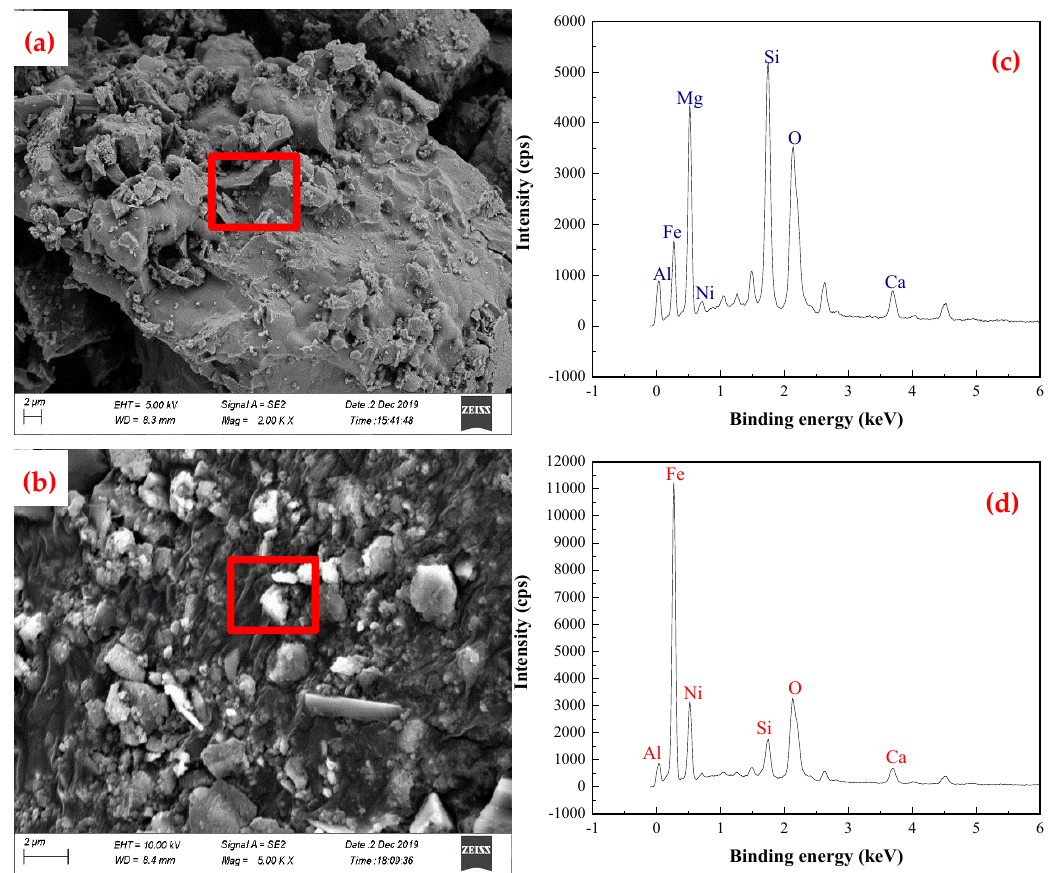
Figure 8. SEM images of the segregation roasting ores ( a ) and ferronickel ( b ); -EDS images of the segregation roasting ores ( c ) and ferronickel ( d